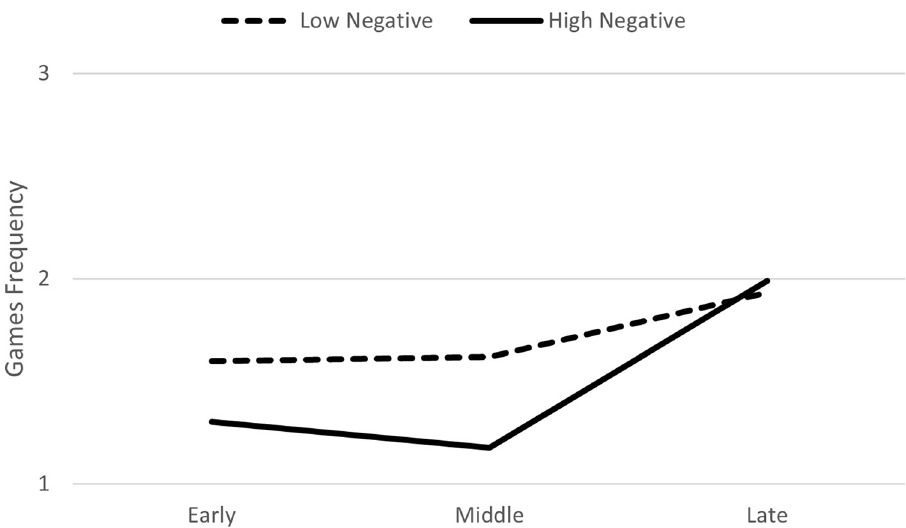
Fig 2. Change over time in frequency of games as function of negative actions in the first phase of the relationship.